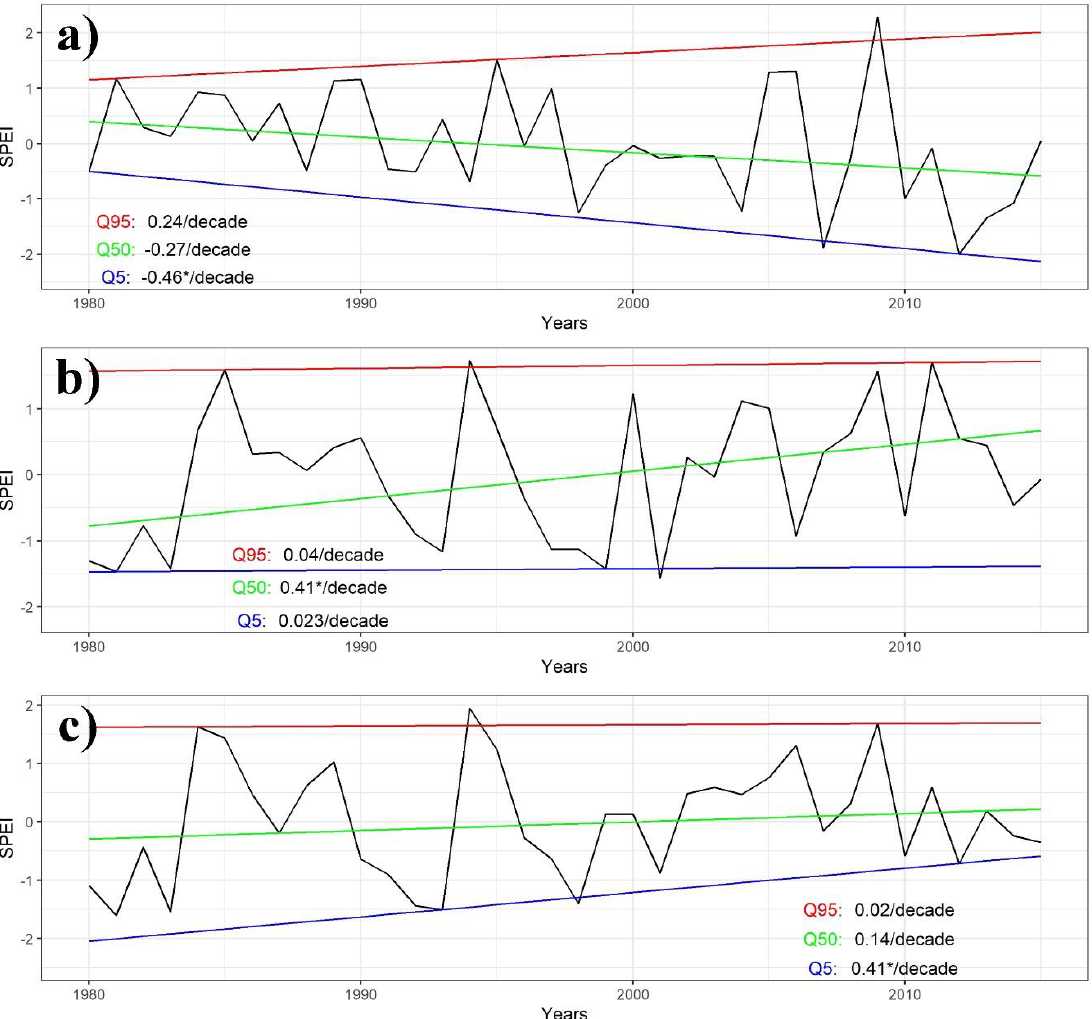
Figure 7. Trends of multi quantile levels of SPEI-3/decade for the MJJ quarter in the cities ( a ) Barreiras (BA), ( b ) João Pessoa (PB), and ( c ) Fortaleza (CE). * Confidence interval used: 95%.